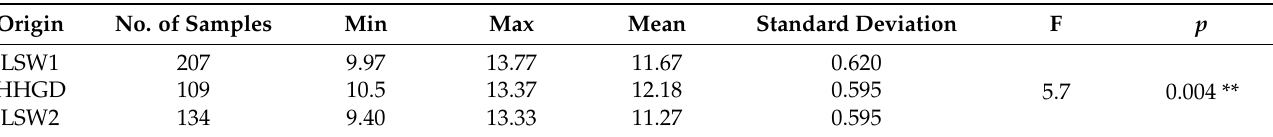
Table 8. Statistical results of the measured fruit soluble solids content (SSC/%) values for all ‘Dang- shan’ pear samples.